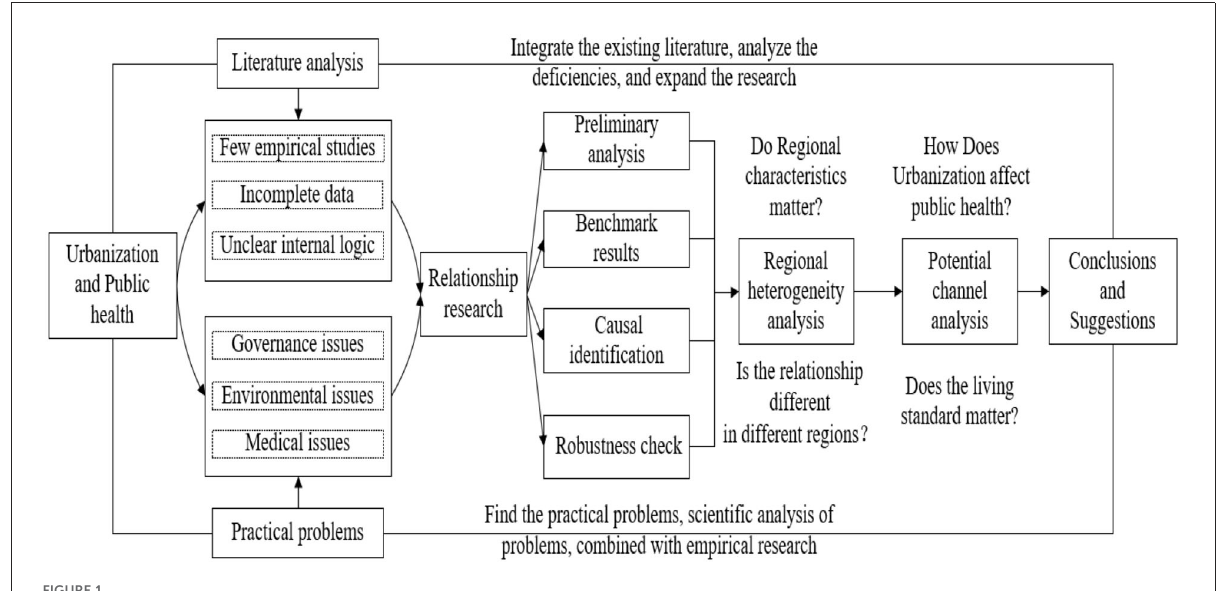
FIGURE1 Research framework of the impact of urbanization on public